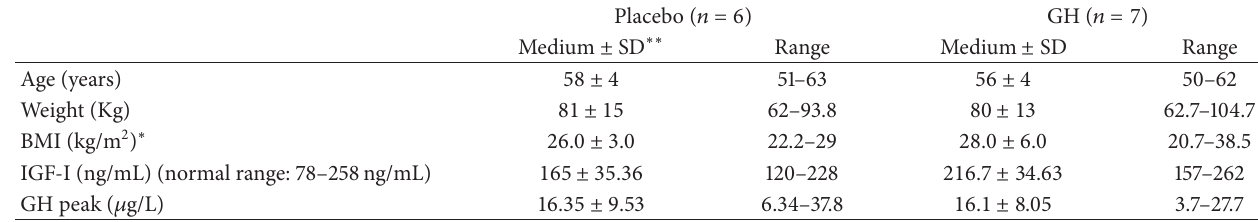
Table 1: Baseline characteristics range (placebo and GH